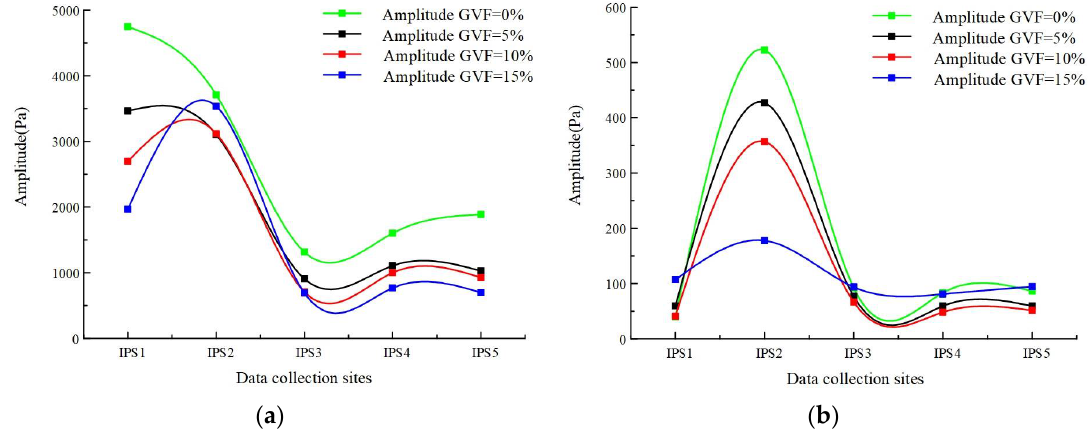
Figure 7. Amplitudes of pressure fluctuations on IPS1-IPS5. ( a ) Dominant frequency; ( b ) secondary frequency.